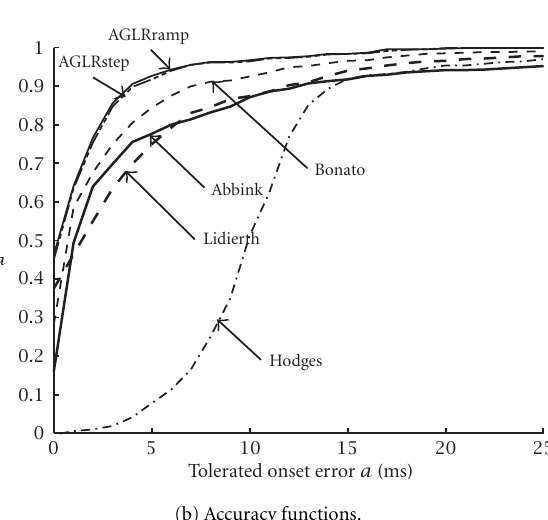
(b) Accuracy functions. Figure 9: Analysis of deviations between estimated change times and expert’s reference obtained on real SEMG signals with different computerized